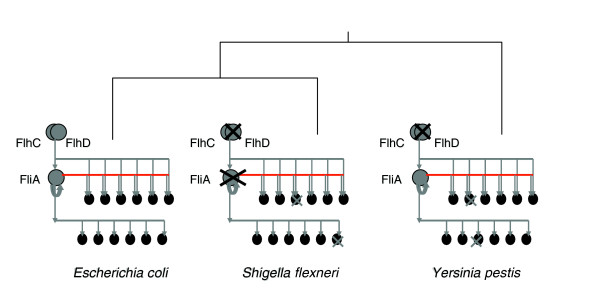
Schematic representation of the flagella biosynthesis regulon. In E. coli K12 the master regulator FlhDC activates the transcription of seven operons, one of which encodes the secondary activator FliA. FliA in turn activates the operons that are regulated by FlhDC, as well as additional operons. Efficient shutdown of flagella synthesis in the non-motile bacteria S. flexneri and Y. pestis is achieved by the loss of the major activator FlhDC. Nonsense mutations in genes of the regulated operons are then gradually accumulated.